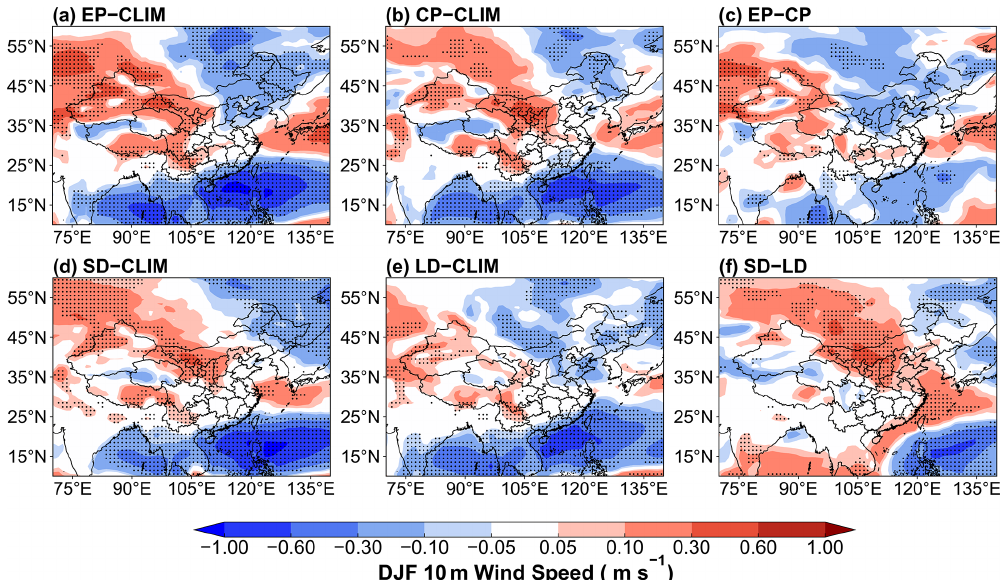
Figure 3. Composite differences in DJF mean 10m wind speed (ms − 1 ) between EP and CLIM in (a) , CP and CLIM in (b) , EP and CP in (c) , SD and CLIM in (d) , LD and CLIM in (e) , and SD and LD in (f) . The stippled areas indicate statistical significance with 90% confidence from a two-tailed t